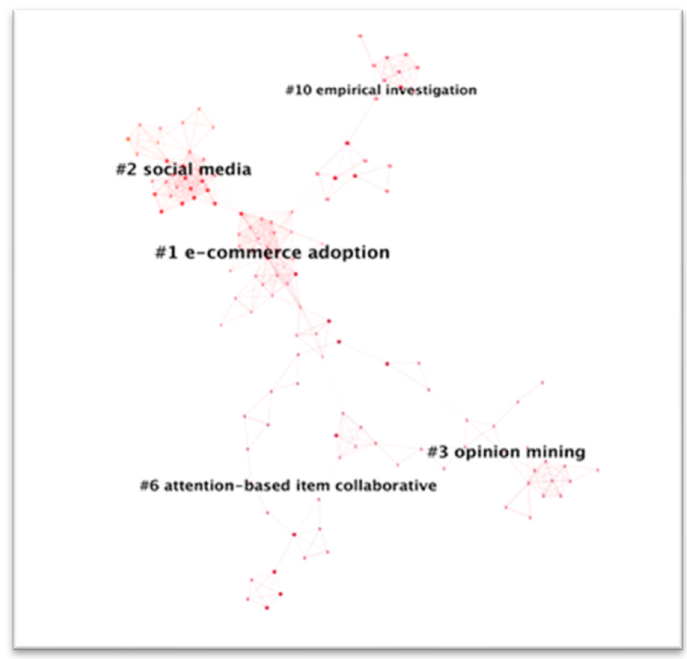
Figure 3. Labelled clusters for electronic commerce, designed by authors. Note: The more obvious the color, the more recent the publications. Table 3. Top terms by cluster labels and indicators for electronic commerce.